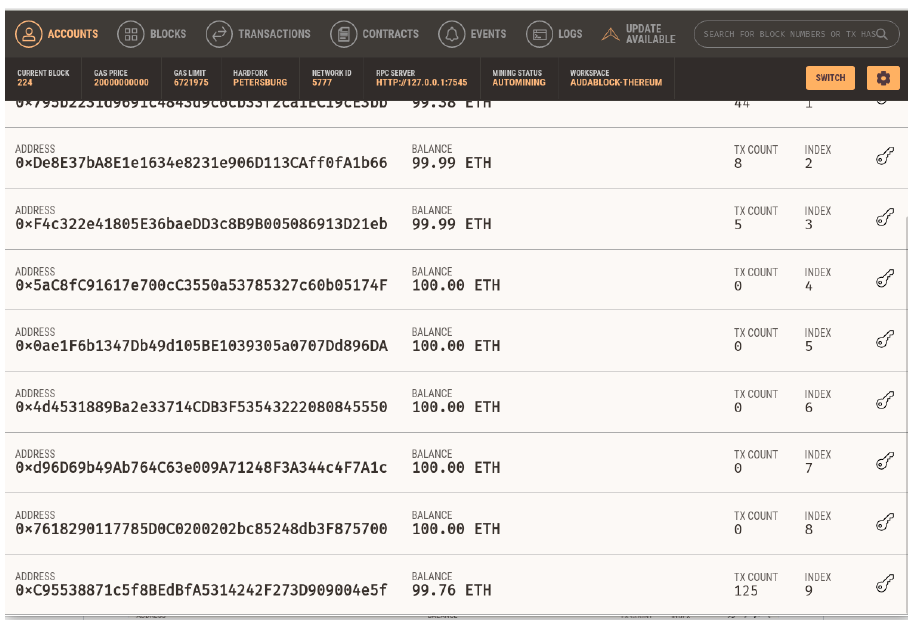
Figure 9. Ganache development